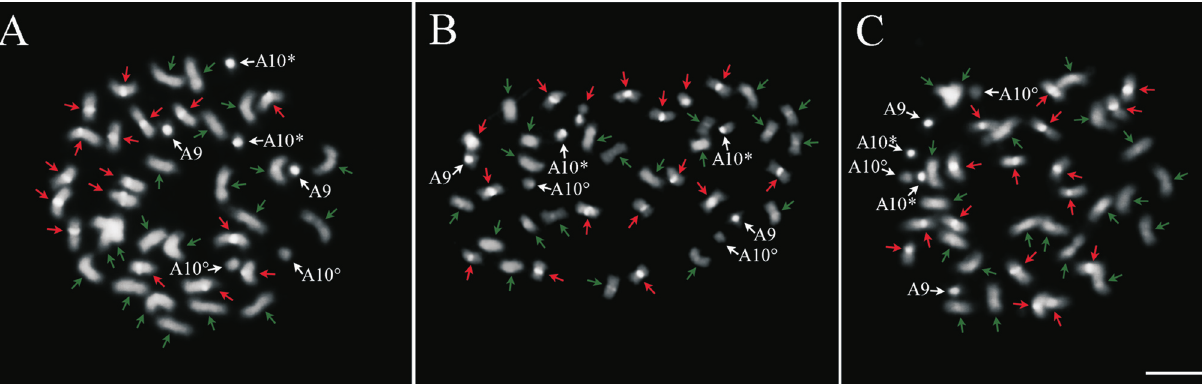
Figure 2 - Metaphase chromosomes after DAPI counterstaining (bright white) in A) Xingu type of 126, representing similar results for the three Xingu accessions; B ) A. hypogaea ‘IAC Tatu-ST’ and C) A. monticola V 14165. Ten pairs of chromosomes show DAPI + bands on centromeric region of A subgenome (red arrows), while the other 10 pairs, corresponding to the chromosomes of the B subgenome, lack DAPI + bands (green arrows). A9: small pair “A”. A10 with secondary constriction, short arm and proximal segment of the long arm (*) and satellite is (°). Bar: 5 (cid:2) m.